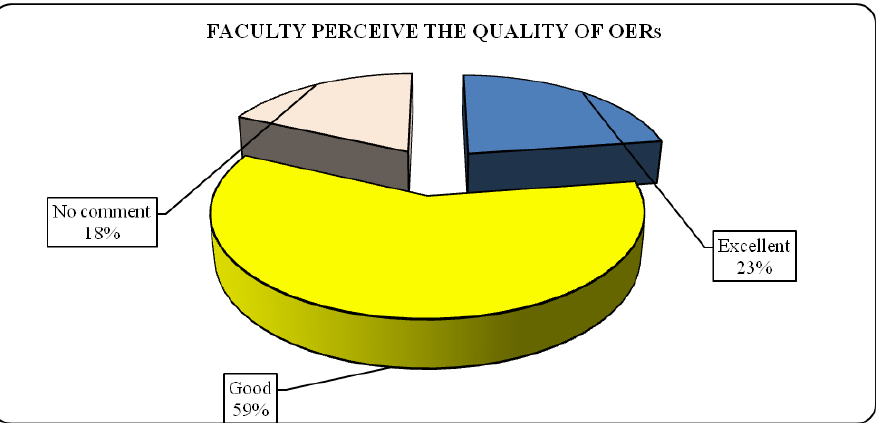
Figure 4 . Perceptions on quality of